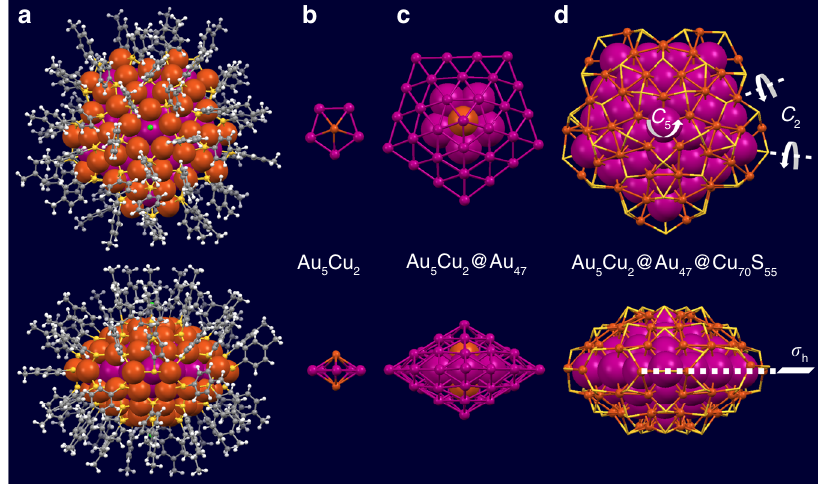
Fig. 1 Structural anatomy of the [Cu 72 Au 52 ( p -MBT) 55 ] + nanoalloy. a total structure of [Cu 72 Au 52 ( p -MBT) 55 ] + in top/side views; b the fi rst Au 5 Cu 2 shell; c the second Au 47 shell; and d the third Cu 70 S 55 cage. Color labels: magenta = Au, orange = Cu, yellow = S, grey = C, and white